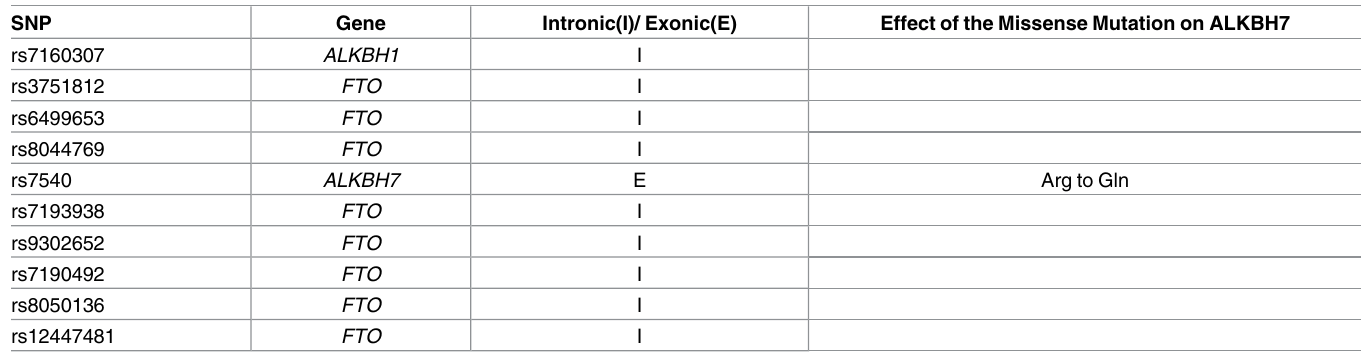
Table 1. SNPs of ALKBH family genes with significant association (p (cid:20) 0.05) with prostate cancer phenotype. SNP Gene Intronic(I)/ Exonic(E) Effect of the Missense Mutation on